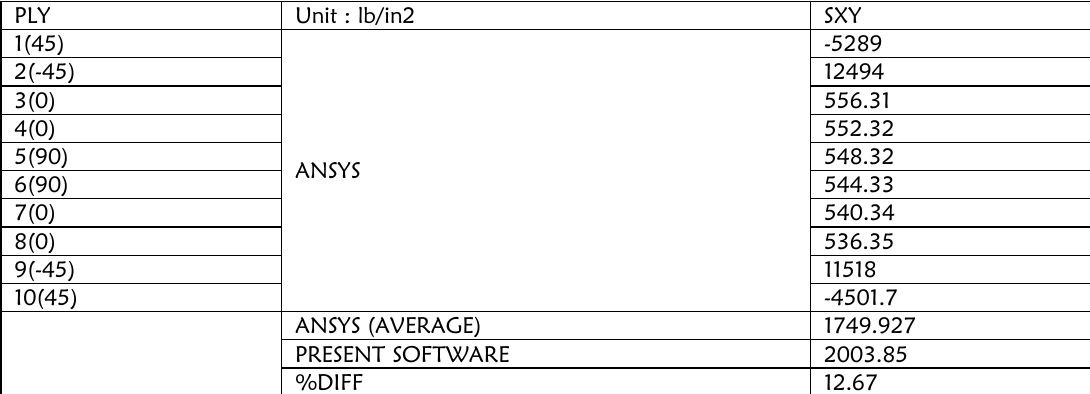
Table 7: Average shear stress on the lower flange of I-beam due to shear force